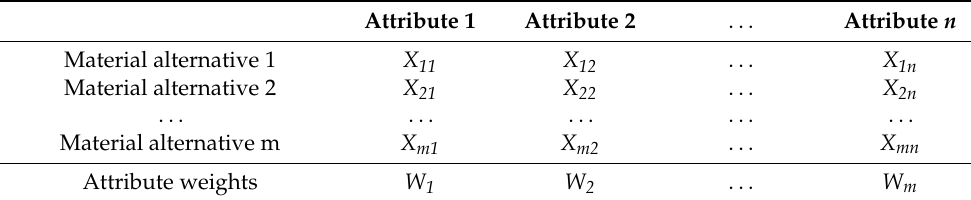
Table 1. MADM performance matrix [29]. Attribute 1 Attribute 2 . . . Attribute n Material alternative 1 X 11 X 12 . . . X 1n Material alternative